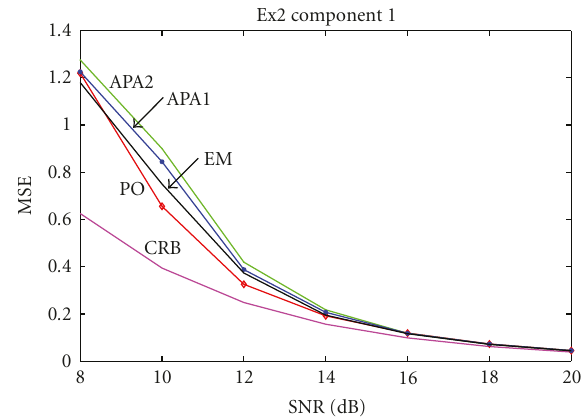
Figure 5: Experimental MSE versus SNR for Ex2 component 1.